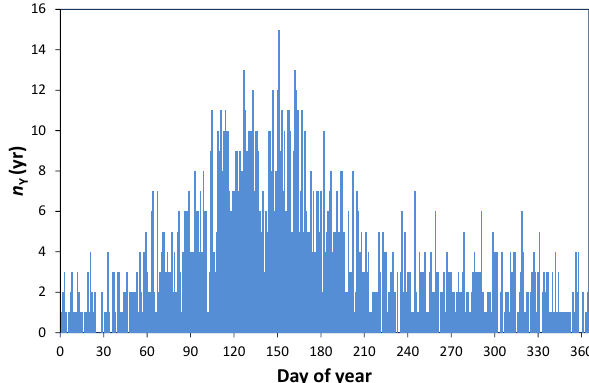
Fig. 5. Distribution of continental USA severe tornadoes ( L ≥ 10km) as a function of day of the year (convective days, 12:00–12:00UTC, i.e. 06:00–06:00CST). The number of years n Y with at least one severe tornado ( L ≥ 10km) is given for each day of the year, 1 to 365 (leap day removed), for the 30-yr period 1982– 2011. Tornado path length data L are from NOAA (2012).